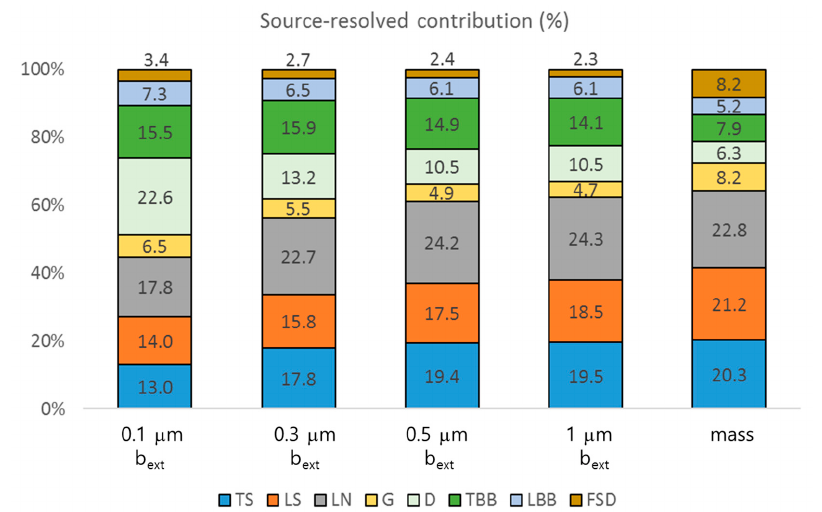
Figure 7. Comparisons of the average source-based mass contribution with the source-based b ext contributions (GSD = 1.5).